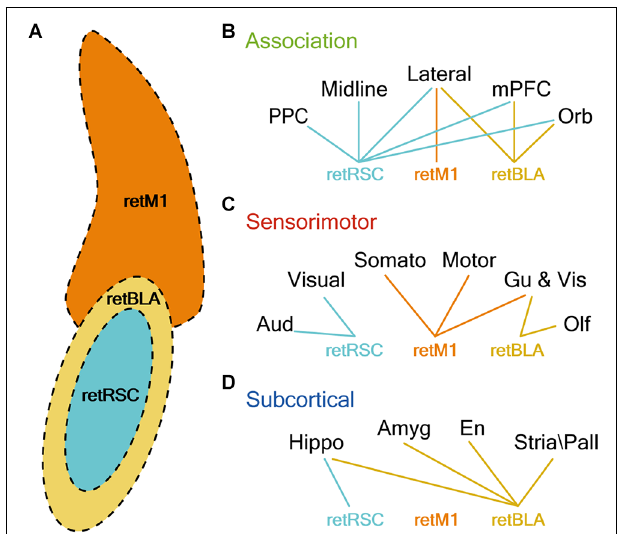
FIGURE 12 | CLA neurons projecting to RSC, M1, and BLA reside in distinct topological locations and strongly innervate distinct sets of brain regions. (A) Illustration of CLA subzones. Colors represent the topological location CLA neurons projecting to M1 (retM1, orange), BLA (retBLA, yellow), and RSC (retRSC, teal). (B–D) Lines represent connection preferences of different CLA projection neurons. Connection preferences are divided into three functional categories: Association (A) , Sensorimotor (B) , and Subcortical (C) . retRSC neurons strongly innervate all association cortices, but only the visual and auditory cortex (sensorimotor) and hippocampal formation (subcortical). retM1 neurons strongly innervate only the lateral association (association), somatosensory, motor, gustatory and visceral cortices (sensorimotor). retBLA neurons strongly innervate only the frontal and lateral association (association), olfactory, gustatory and visceral cortices (sensorimotor), and all subcortical targets